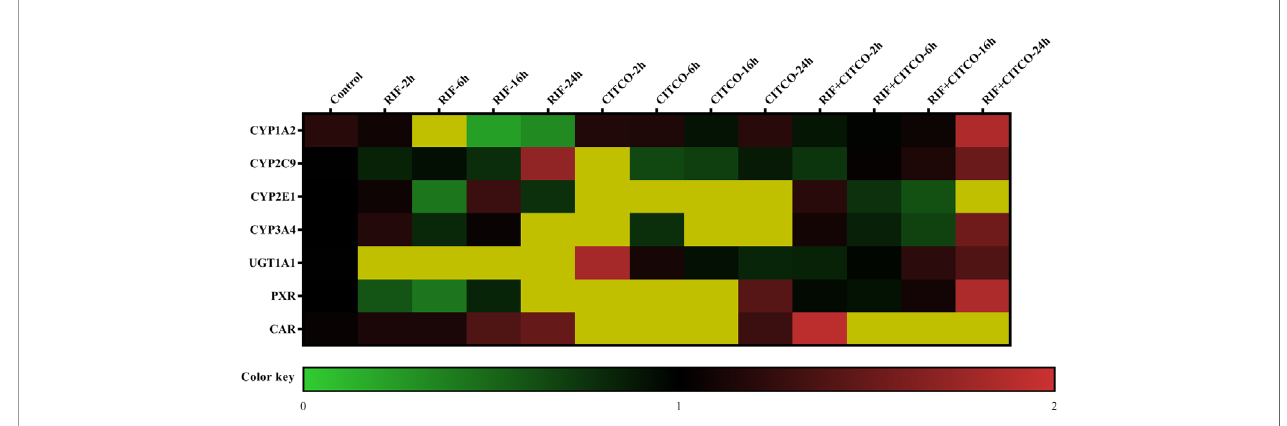
FIGURE 10 | mRNA expression of CYP1A2, CYP2C9, CYP2E1, CYP3A4, and UGT1A1 following treatment with Rif and CITCO. HepG2 cells treatment with Rif or COTCO in normoxia, and the mRNA expression of CYP1A2, CYP2C9, CYP2E1, CYP3A4, and UGT1A1 were detected. The mRNA expression levels of CYP450 and UGT1A1 genes are shown using the indicated pseudocolor scale from 0 (green) to 2 (red) relative to the value for HepG2 cells in the control group. The color scale represents the relative mRNA expression levels, with green indicating down-regulated genes, red indicating up-regulated genes, dark yellow indicating over 2- fold up-regulated genes, and black indicating unchanged genes. Rif (rifampicin): PXR agonist, CITCO (6-(4-chlorophenyl)-imidazo (2,1-b) thiazole-5-carbaldehyde): CAR